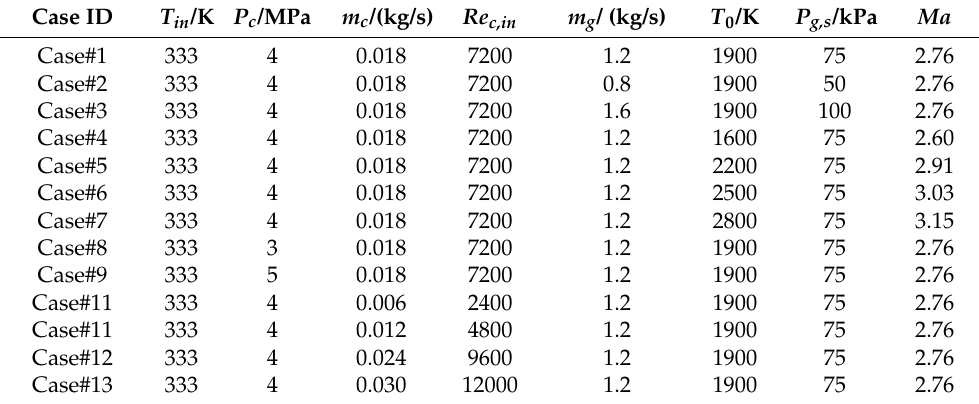
Table 1. Numerical parameters in different